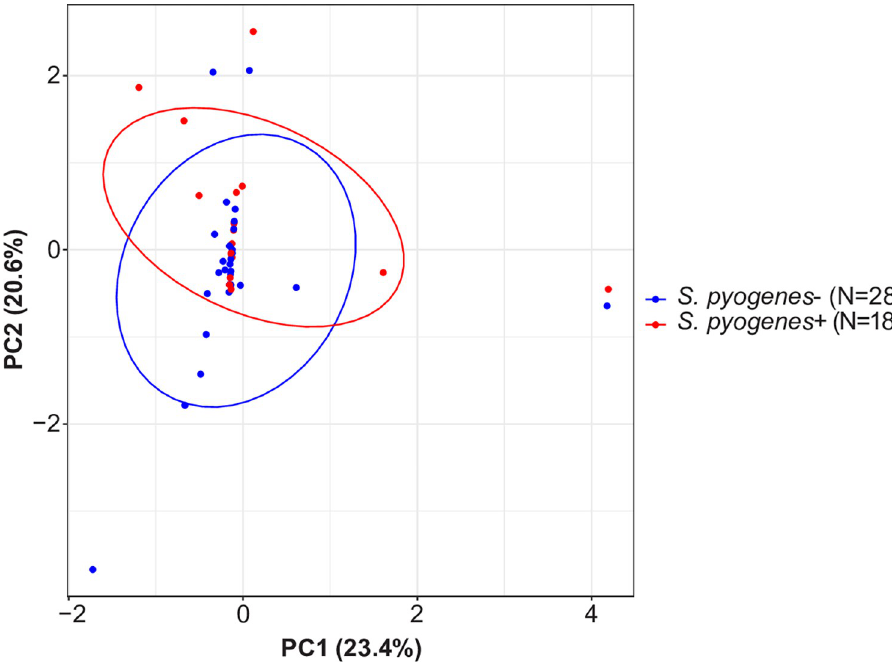
Fig 3. Principal component analysis of idiopathic ulcers grouped by presence or absence of S . pyogenes . IU specimens in the stringent dataset were sub-grouped based on if they contained S . pyogenes sequences, followed by transformation using additive log ratio with human reads as the invariant taxon. A PERMANOVA comparison between groups shows a significant difference (P < 0.05).